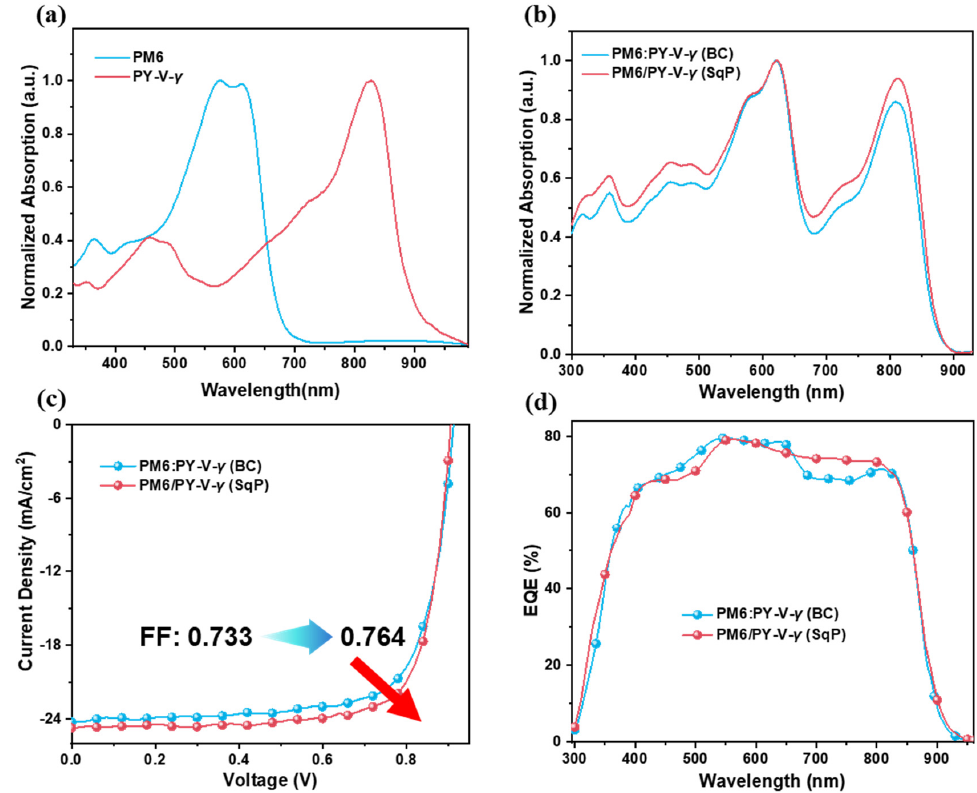
Figure 2. ( a ) UV-Vis absorption spectra of pure PM6 and pure PY-V- γ . ( b ) UV-Vis absorption spectra of blend films of PM6 and PY-V- γ made from BC or SqP. ( c ) External quantum efficiency (EQE) spectra of the BC and SqP devices. ( d ) Current density-voltage ( J - V ) curves. Table 1. Summary of photovoltaic parameters for PM6 and PY-V- γ based all-PCSs processed from different methods, measured under AM 1.5 G illumination at 100 mW cm − 2.